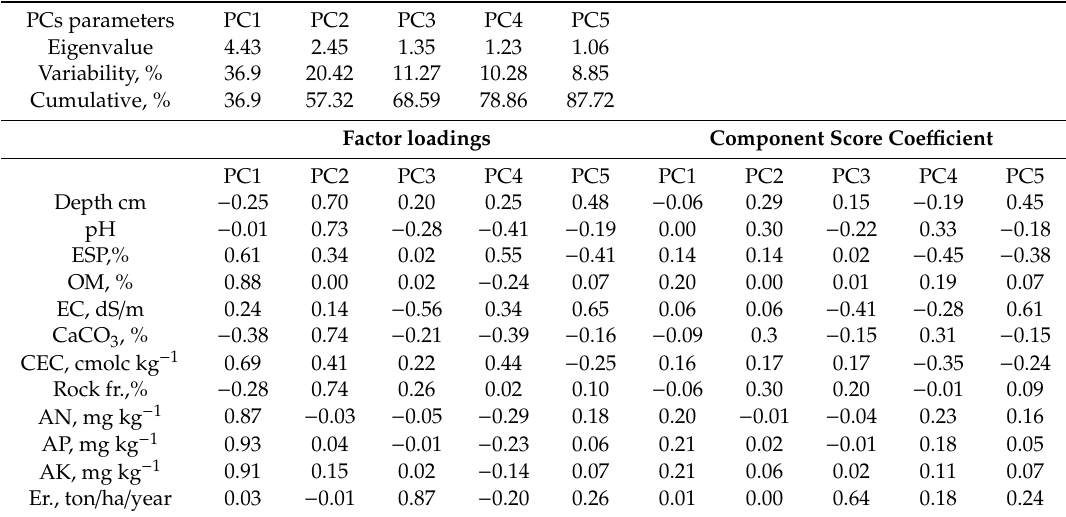
Table 4. Summarization of the principal component analysis (PCA) analysis.